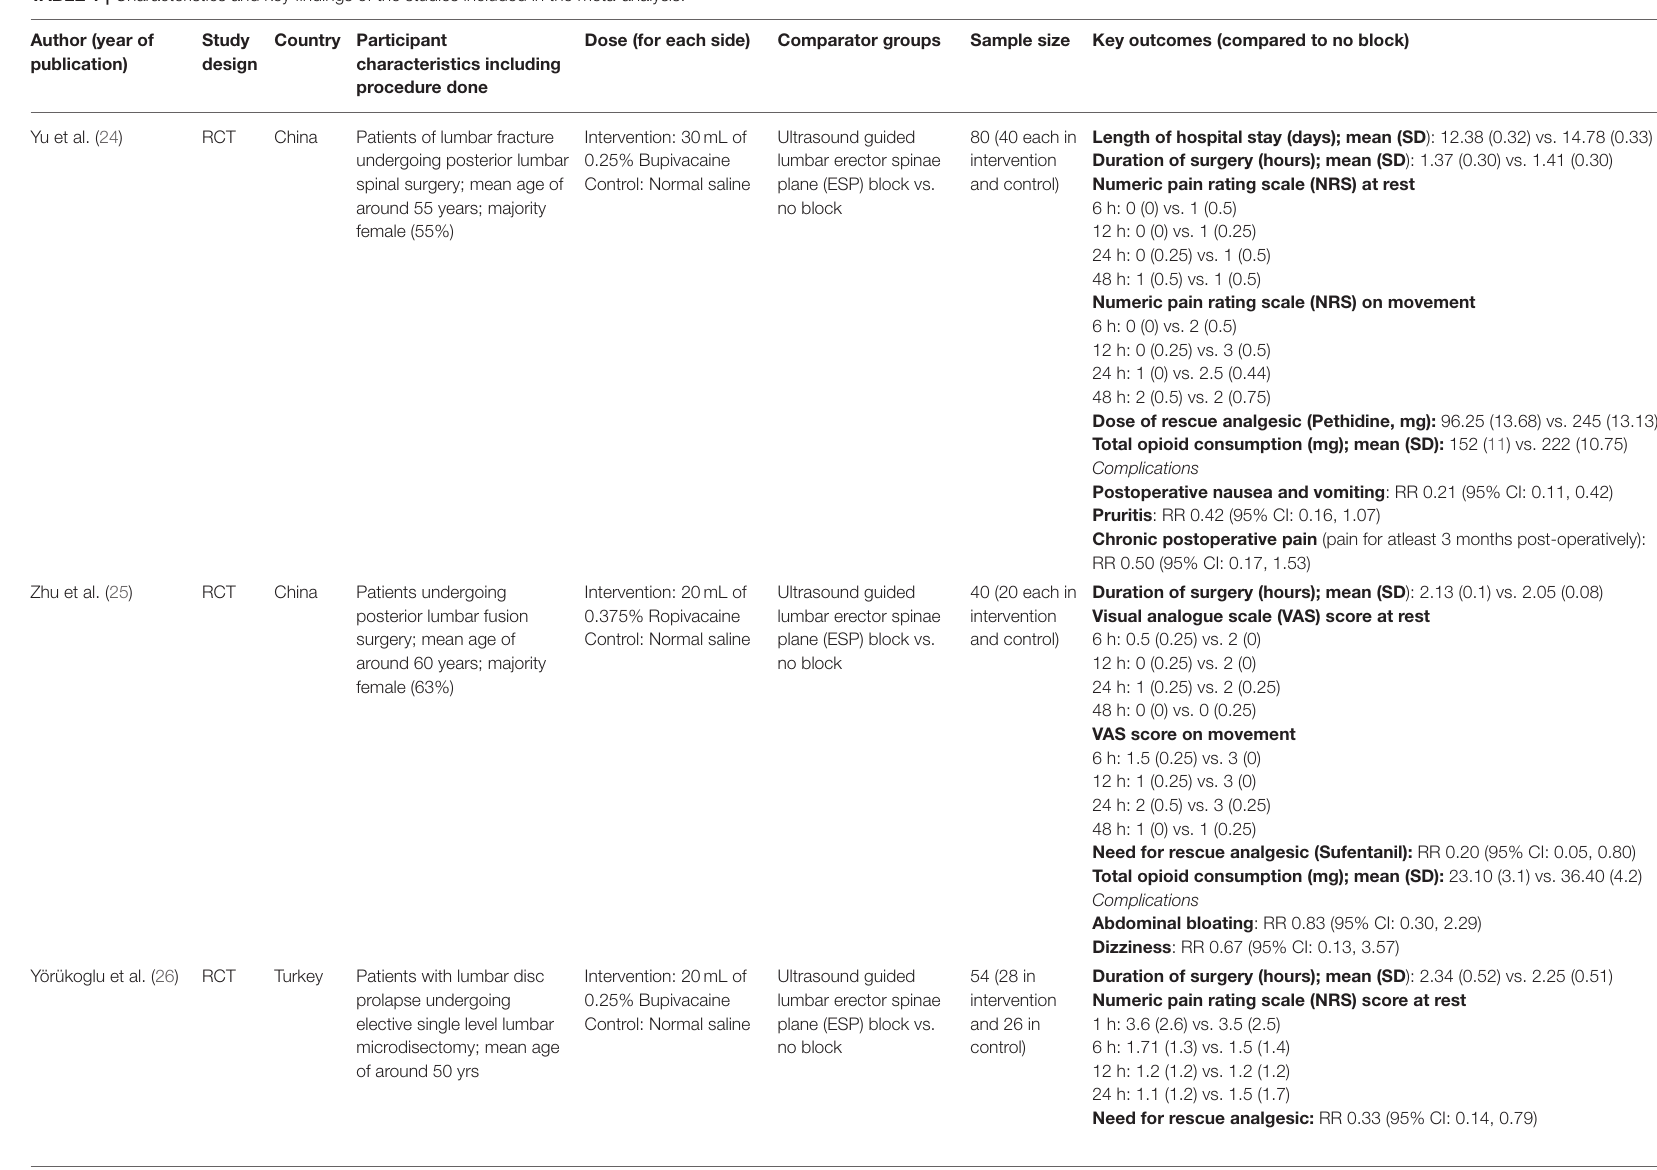
TABLE 1 | Characteristics and key findings of the studies included in the meta-analysis. Author (year of